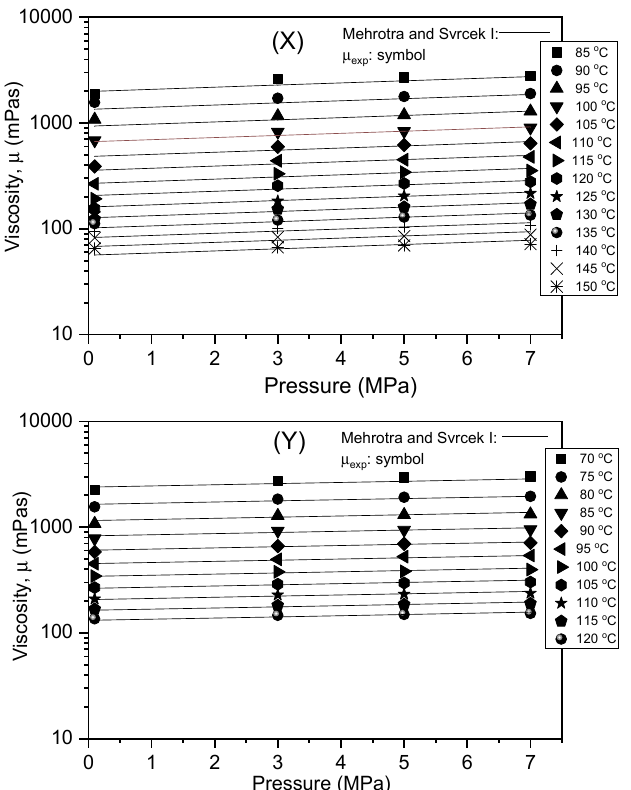
Figure 6. Experimental and calculated viscosities using Equation (3).